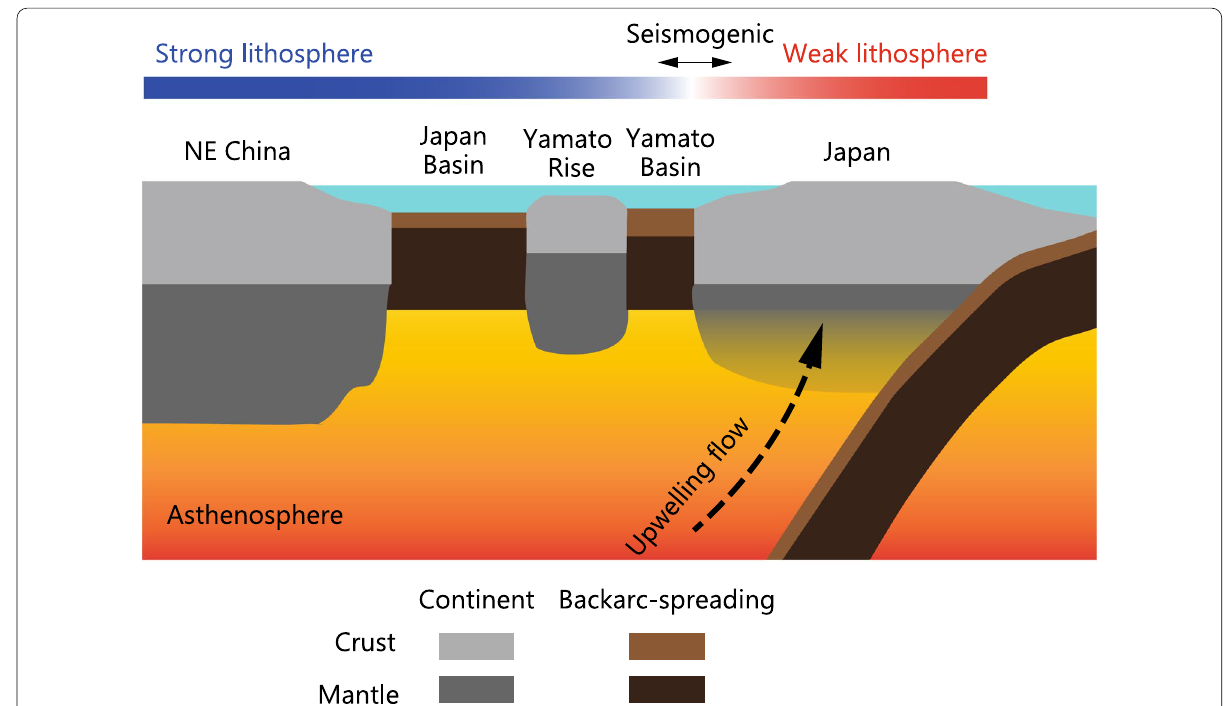
Fig. 12 Schematic illustration of the lithosphere–asthenosphere system across northeastern Japan, the Sea of Japan, and northeastern